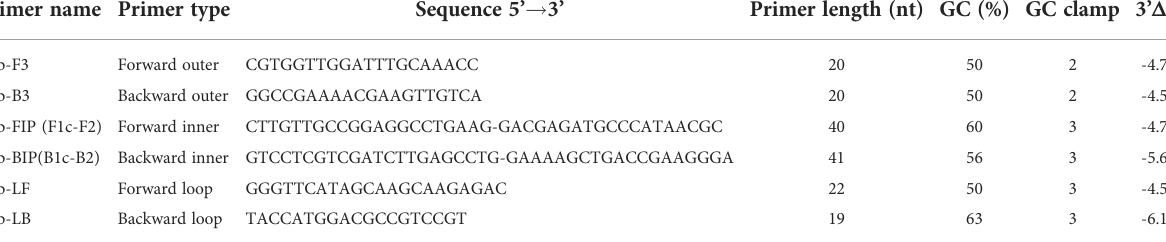
TABLE 1 Sequence of oligonucleotide primer sets used for ampli fi cation of target sequence in b -tubulin gene in this study. Primer name Primer